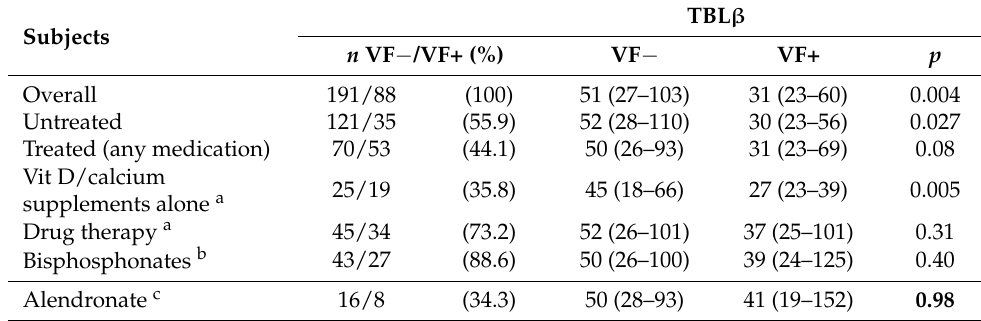
Table 3. TBL β as an index of therapy efficacy on osteoporotic fracture